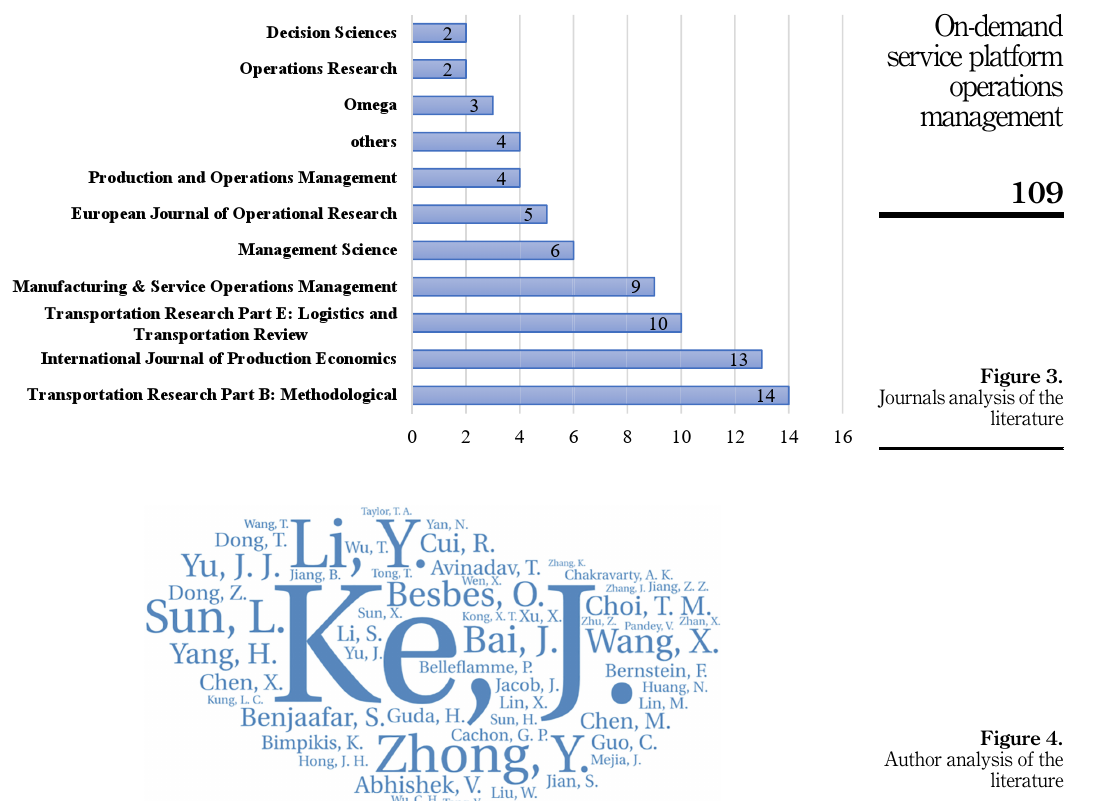
Figure 4. Author analysis of the literature